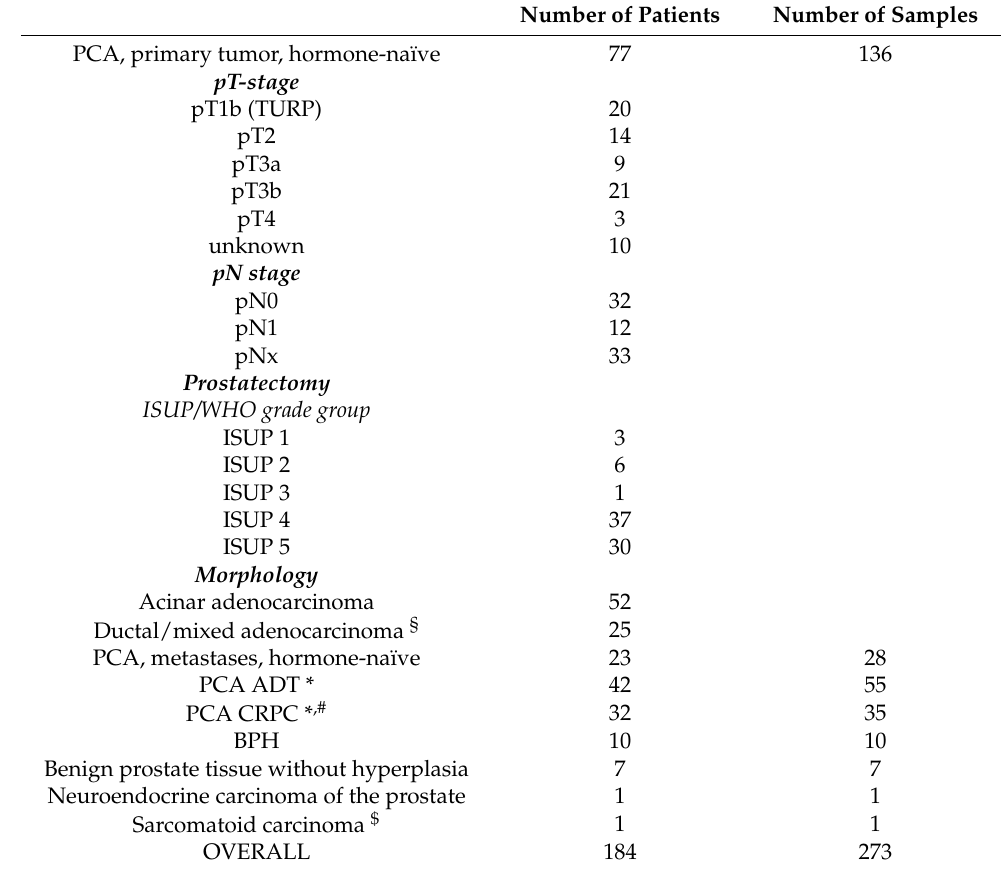
Table 1. Clinical characteristics of the study